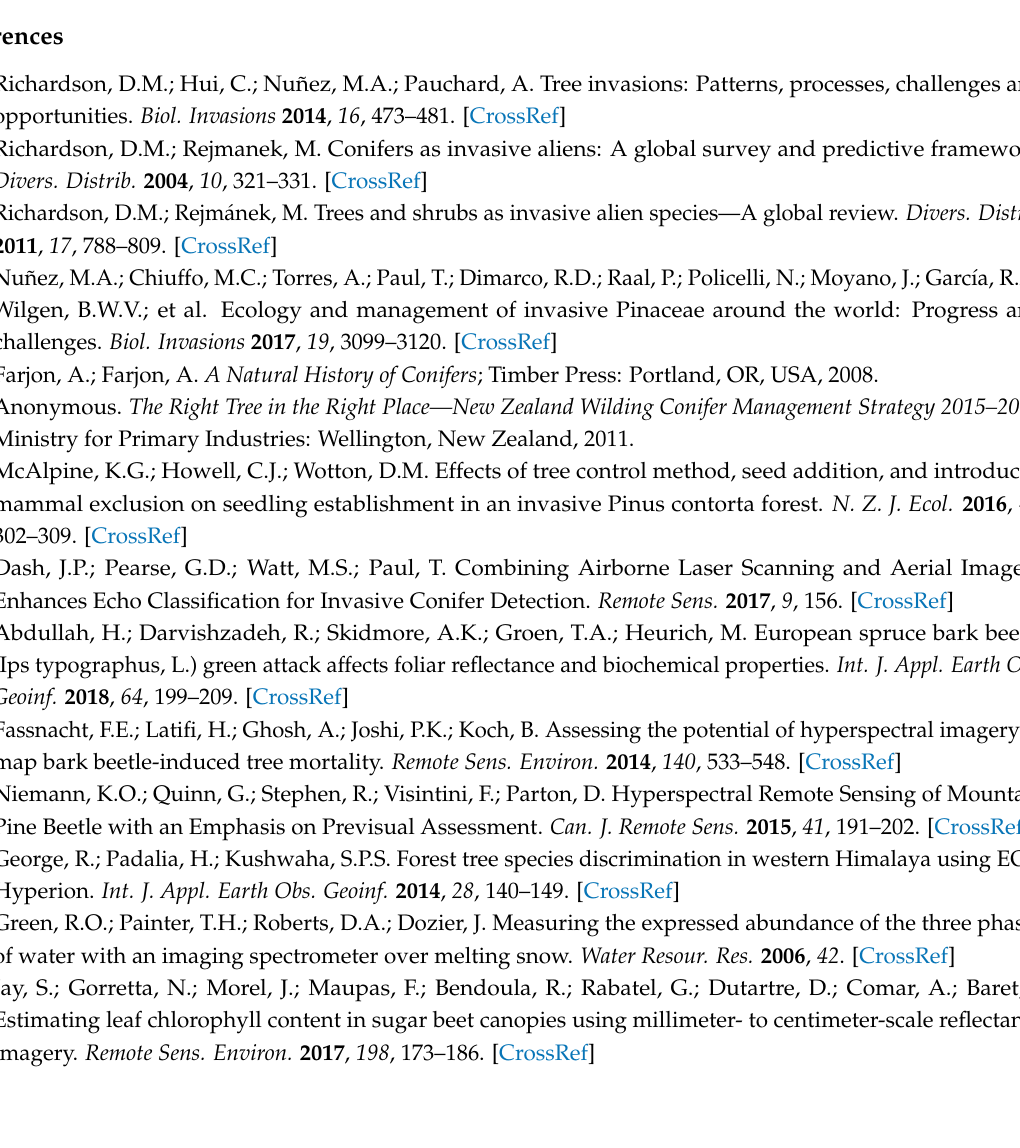
s1, Figure S1: True color depictions Capture 0, 2018-03-15; Figure S2: True color depictions Capture 1, 2018-03-22; Figure S3: True color depictions Capture 2, 2018-03-27; Figure S4: True color depictions Capture 3, 2018-04-04; Figure S5: True color depictions Capture 4, 2018-04-12; Figure S6: True color depictions Capture 5,